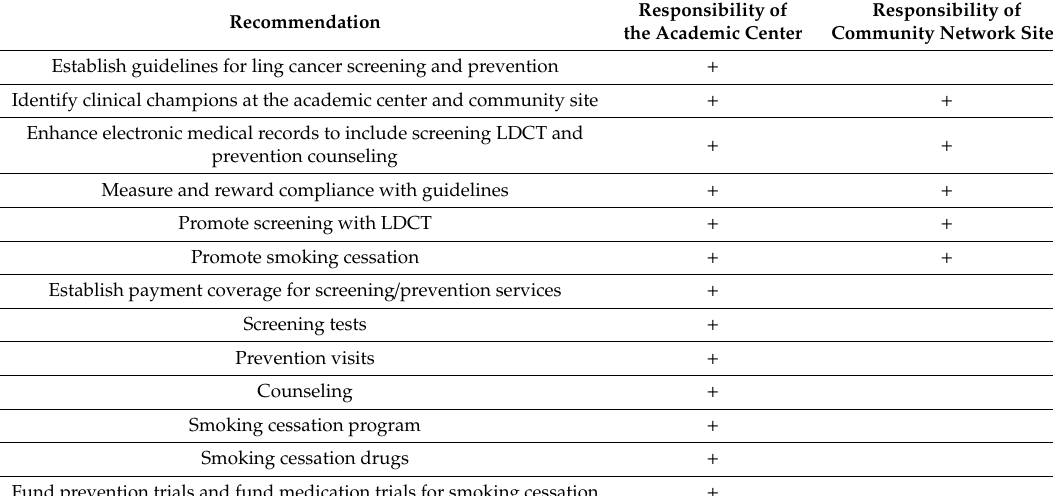
Table 3. Recommendations for Improving Integration of Lung Cancer Screening and Prevention in Clinical